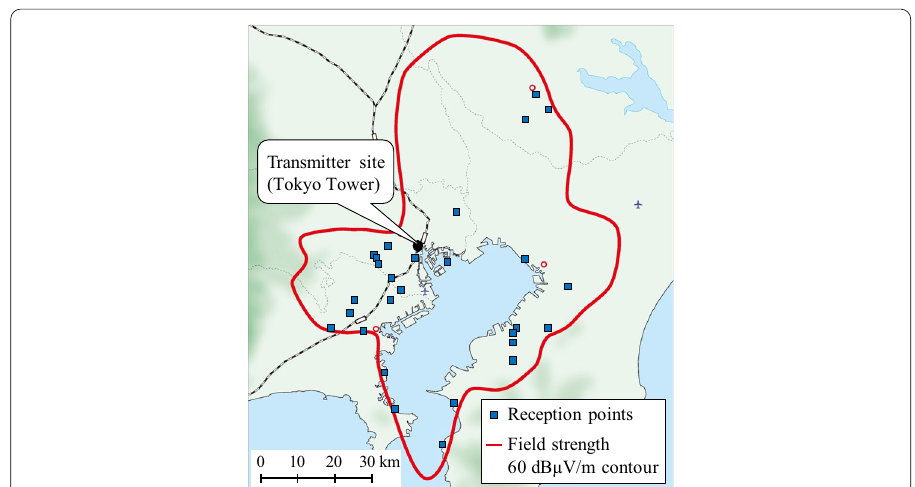
Fig. 8 Location of experimental test station and contour